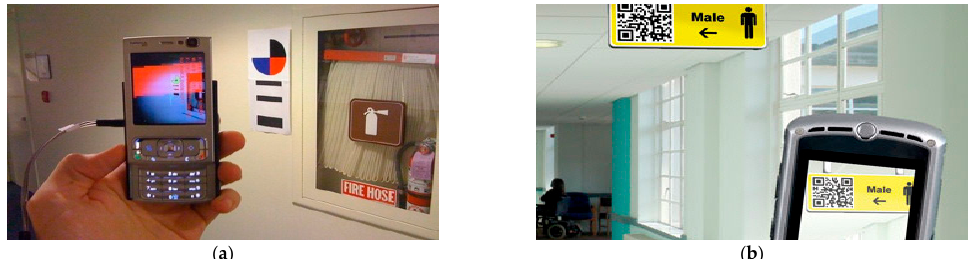
Figure 1. Indoor wayfinding system using color codes: ( a ) Wayfinding using color barcodes and color targets [30]; ( b ) Using quick response (QR) codes